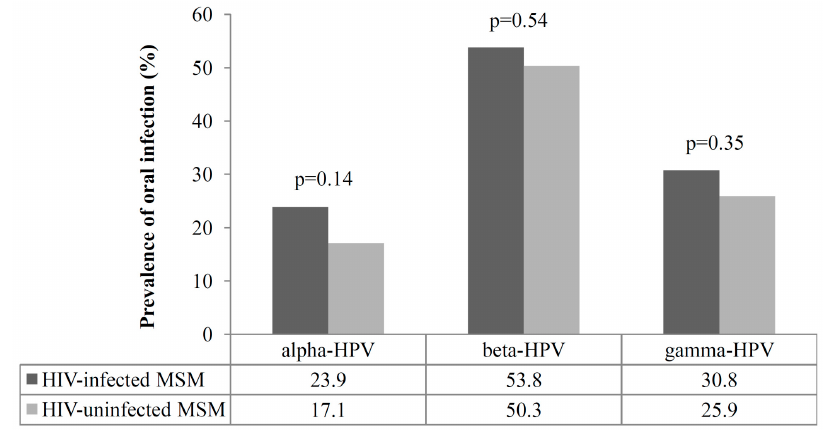
Figure 1. Prevalence of alpha, beta, and gamma HPVs in the oral samples collected from 310 men who have sex with men (MSM), according to HIV status; p values for the comparison between HIV-infected and uninfected subjects are shown.